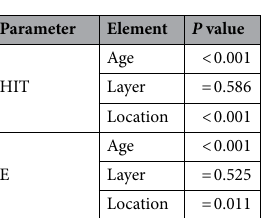
Figure 7. Multi-way analysis of variance of HIT and E based on different ages, layers and locations. The ( a ) and ( c ) show the statistical description of HIT and E of ages at the same layers and location. The ( b ) and (d) show the statistical description of HIT and E of location at the same layers and ages. And the group with statistical significance are connected by straight lines.